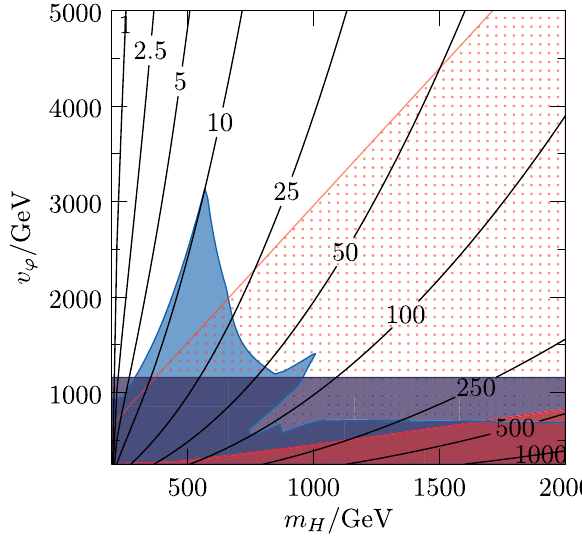
Fig. 3 The parameter space on the v ϕ vs. m H plane with δ m = 0 GeV. Theblacklinesarecontoursofthedilatonmass m ϕ / GeV.Thecouplings are non-perturbative in the red region (not perturbative up to the Planck scale in the red dotted region). The blue region is forbidden by the mixing of other scalars with the Higgs boson and the violet region by the Higgs invisible width from Higgs decay into majorons